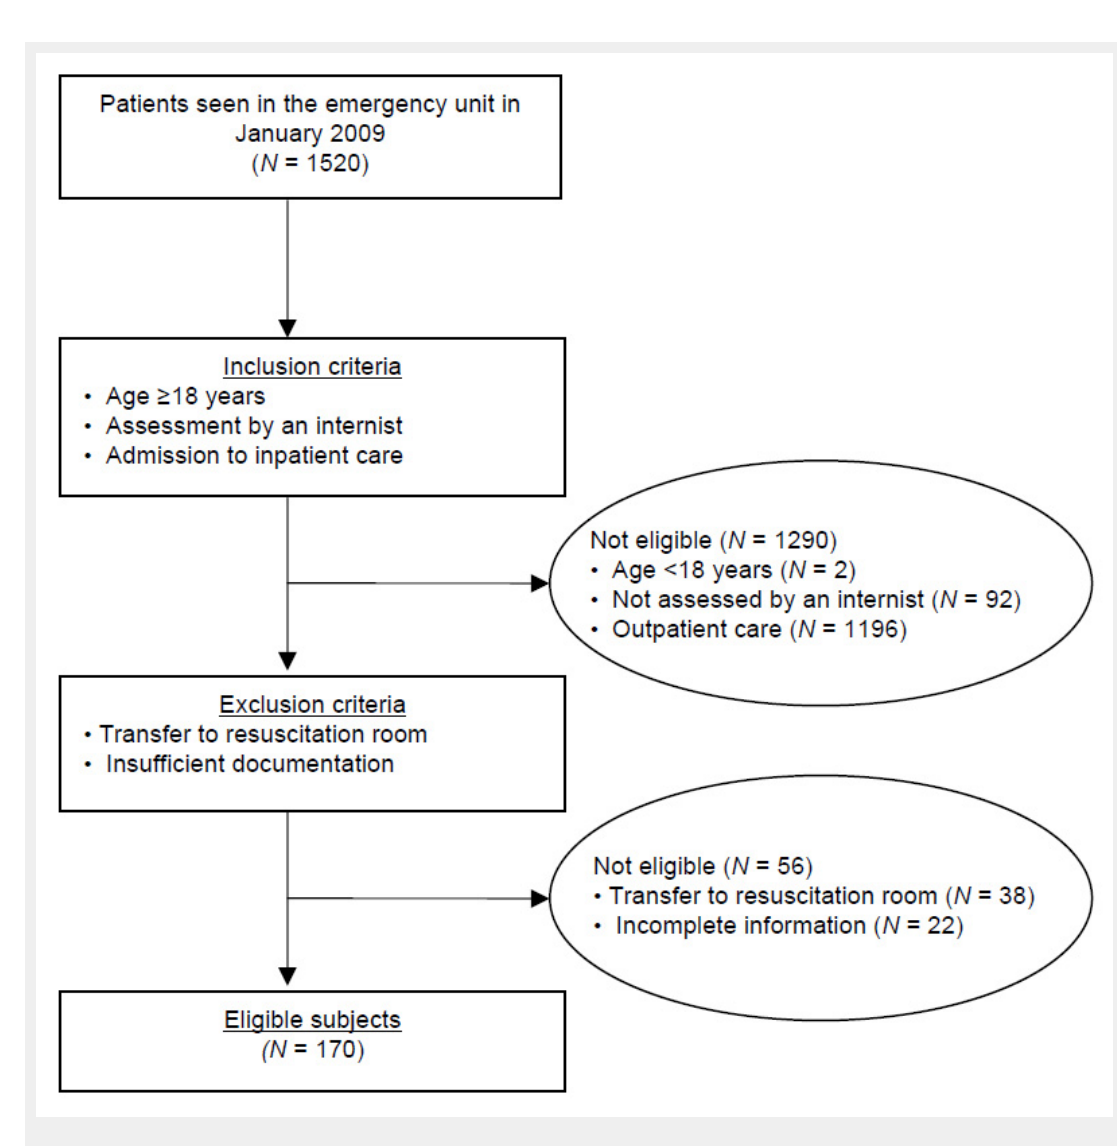
Identification and construction of the study cohort. In the study cohort, we included all adult patients (age ≥18 years) admitted from the emergency unit to the medical wards of the University Hospital Zurich between January 1st and January 31st, 2009. Patients managed primarily by an anaesthesiologist in the resuscitation room, and those with missing diagnostic information were